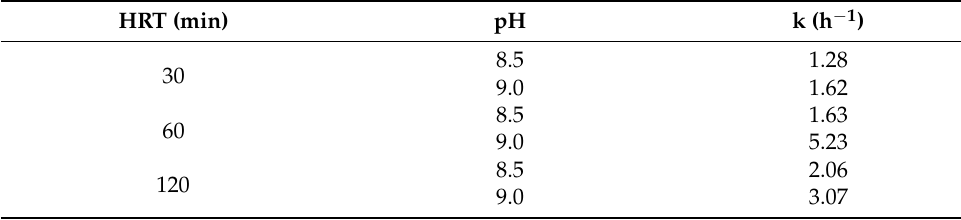
Figure 6. Kinetic models of P removal.: ( a )log plots, HRT 30, 60 and 120 min. (Left to right). ( b ) data plots, HRT 30, 60 and 120 min. (Left to right). Table 4. Phosphorus removal rate